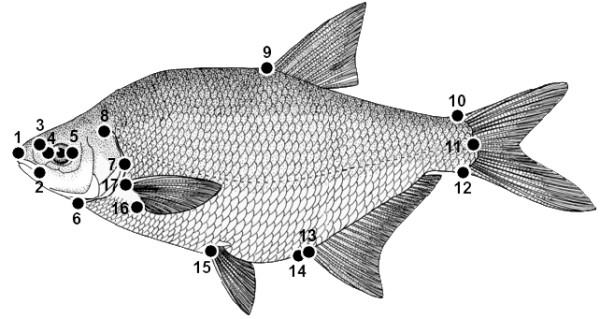
Growth analysis of roach, bream and hybrids in all lakes. Growth rate of bream, roach and hybrids derived from mean length-at-age measurements fitted with best fit logarithmic trend lines. Bream, hybrids and roach are displayed as circles, triangles and diamonds respectively, error bars detail standard deviation.